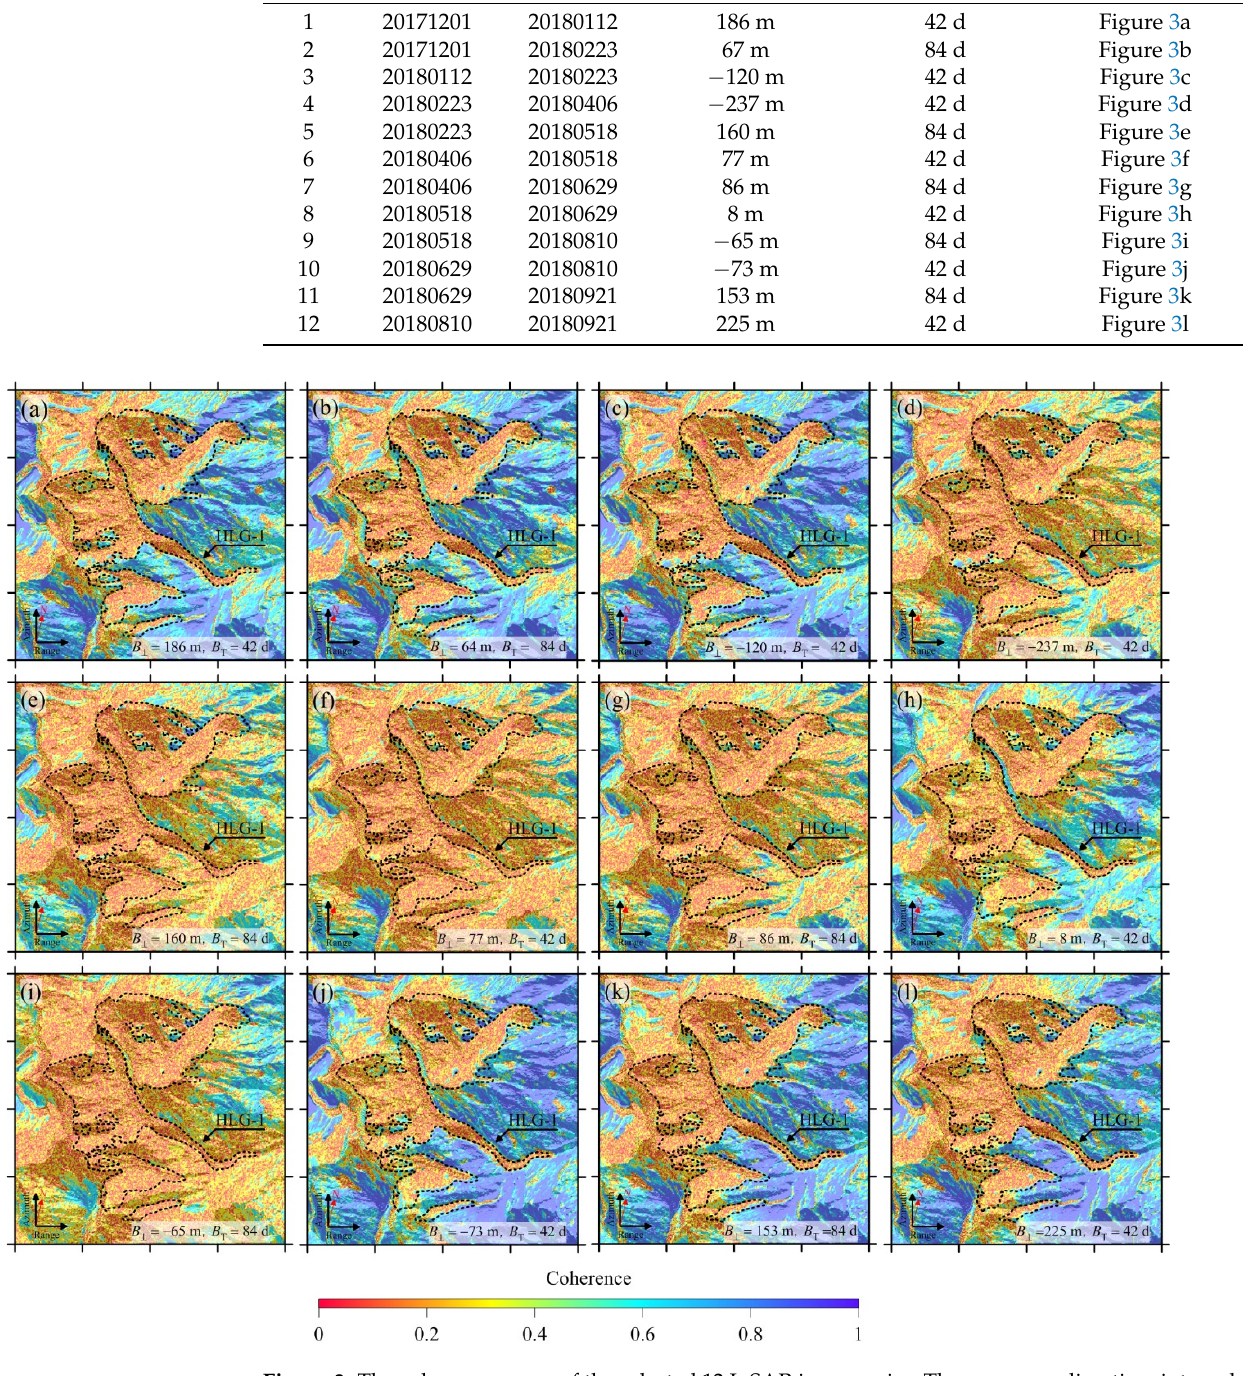
Figure 3. The coherence maps of the selected 12 InSAR image pairs. The corresponding time intervals and perpendicular baselines are given in the lower right corner of each subfigure ( a – l ). As analyzed previously, Figure 3 shows the stable low coherence characteristics of the glacier-covered area, while for non-glacial areas, the coherence has a significant variation in the time series. In addition, we did not observe significant correlations of coherence with temporal and spatial baselines. However, the coherence of image pairs spanning the cool and warm seasons shows more severe decoherence. This suggests that seasonal ground surface variation may be the most significant factor influencing